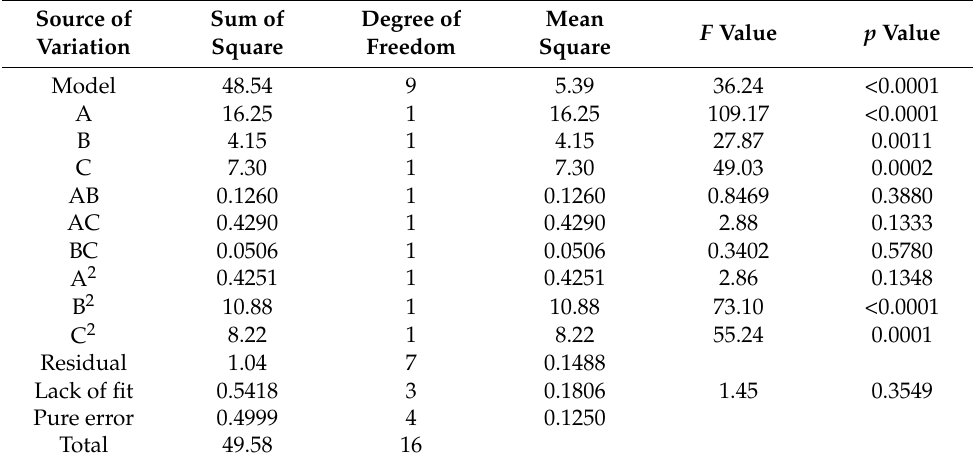
Table 2. Analysis of variance results (Loquat